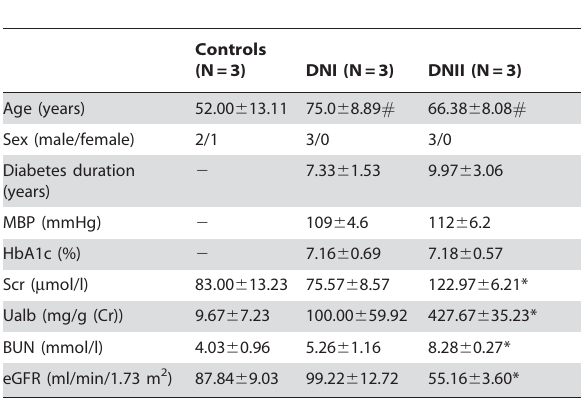
Table 1. Primary clinical and laboratory characteristics of the study subjects.